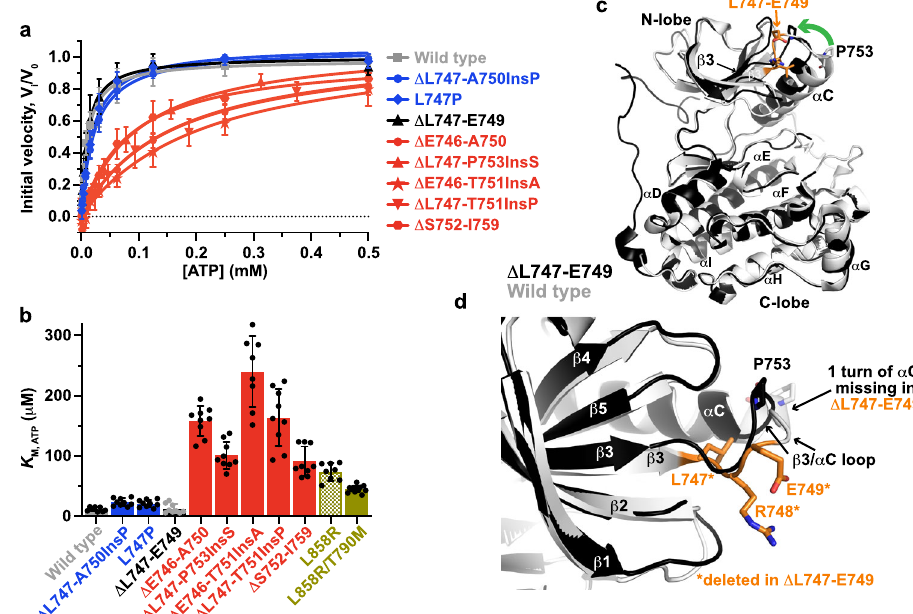
Fig. 3 | TKI sensitivity of exon 19 variants is determined by K M, ATP . a Michaelis- Menten plots for the indicated EGFR kinase domains in the presence of 20 μ M peptide substrate ( n =3 separate protein preparations, with three independent experiments for each) with the TKD concentrations listed in Methods. Normalized mean initial velocity data were plotted against ATP concentration (error bars represent SD across replicates) and fi t to the Michaelis – Menten equation to obtain values for K M, ATP . b The mean value of K M, ATP obtained by fi tting data from indi- vidualATPconcentrationseriesisplotted(±SD).Thebarforwildtypekinaseisgrey, pro fi le 1 variants in blue, pro fi le 2 variants in red, L858R variants in olive, and the unactivated Δ L747-E749 variant in black. Data represent three separate protein